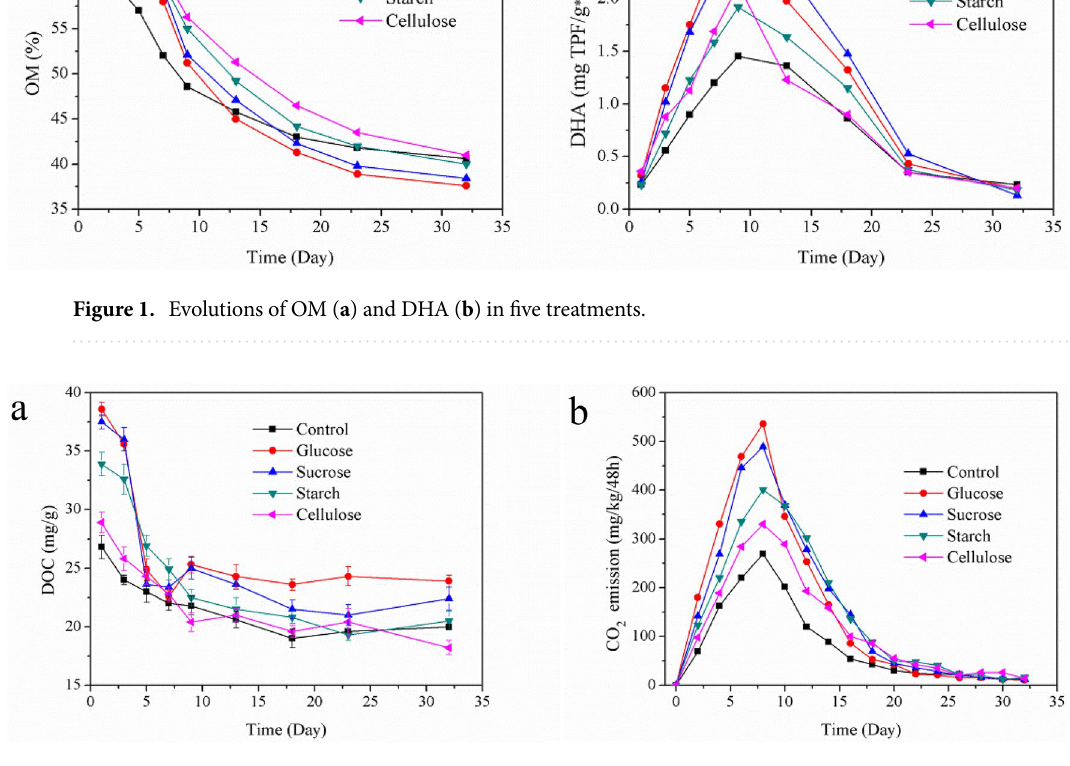
Figure 2. Evolutions of DOC ( a ) and CO 2 emission ( b ) in five